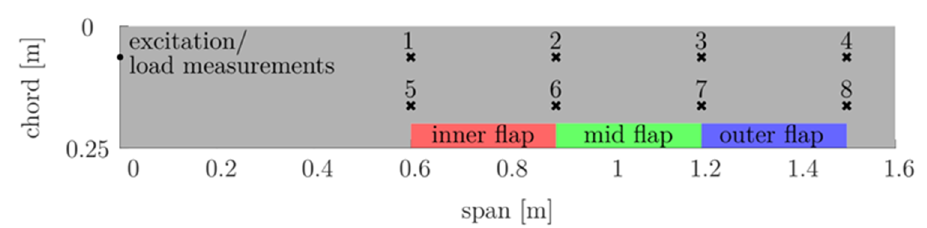
Figure 12. Position of flaps and sensors on the wing.